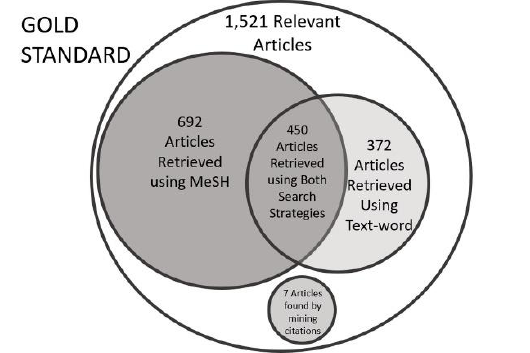
Figure 2 Relationship of sources found by each